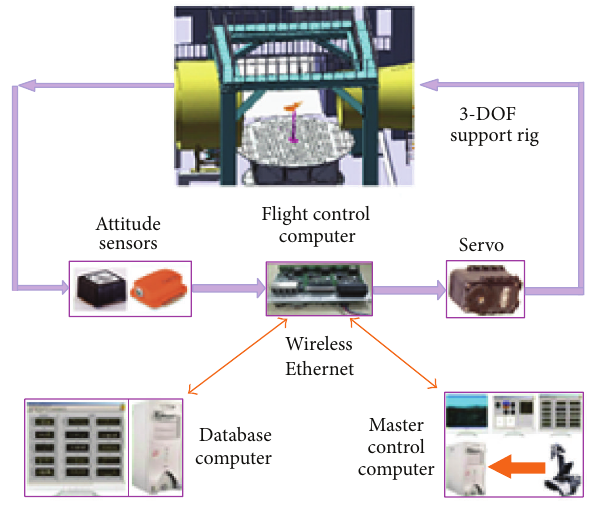
Figure 28: Scheme of VFT system designed by Low Speed Aeronau- tics Institution in CARDC